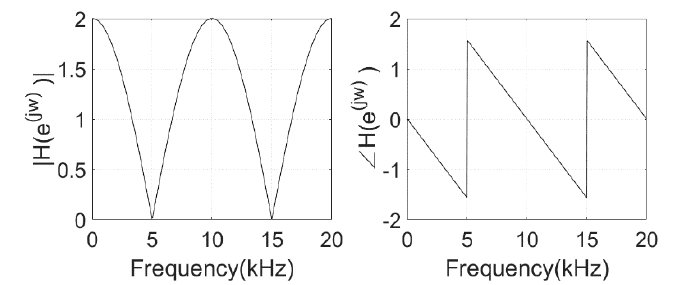
Figure 6. Amplitude–frequency response curve (left) and phase–frequency response curve (right).